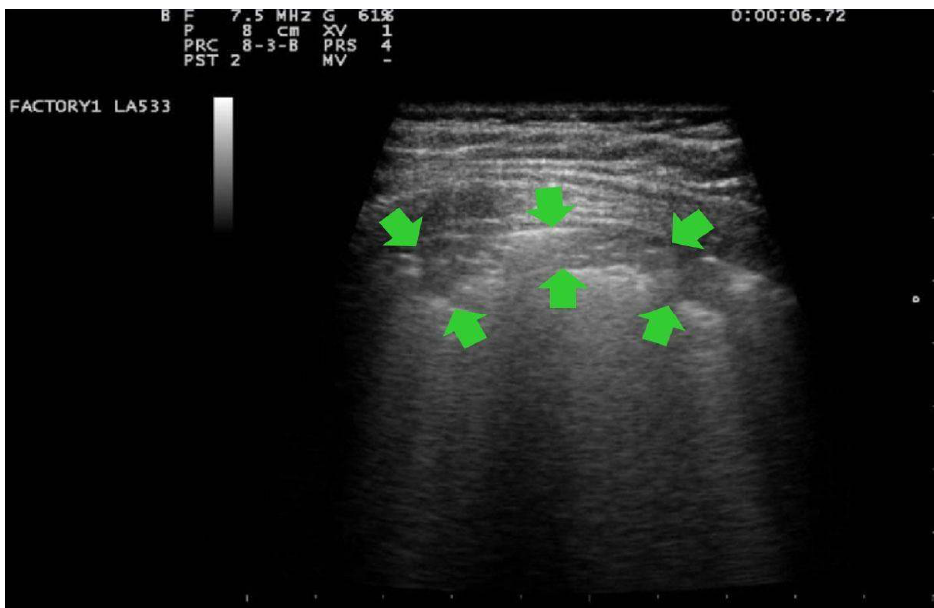
Figure 4. LUS image of the patient with extensive pneumonia obtained with linear transducers, frequency 7.5 MHz, focus on the pleural line. Trapezoidal view. Presence of large consolidations (at least >1 cm) (indicated by green arrows). This pattern is classified as score 3.